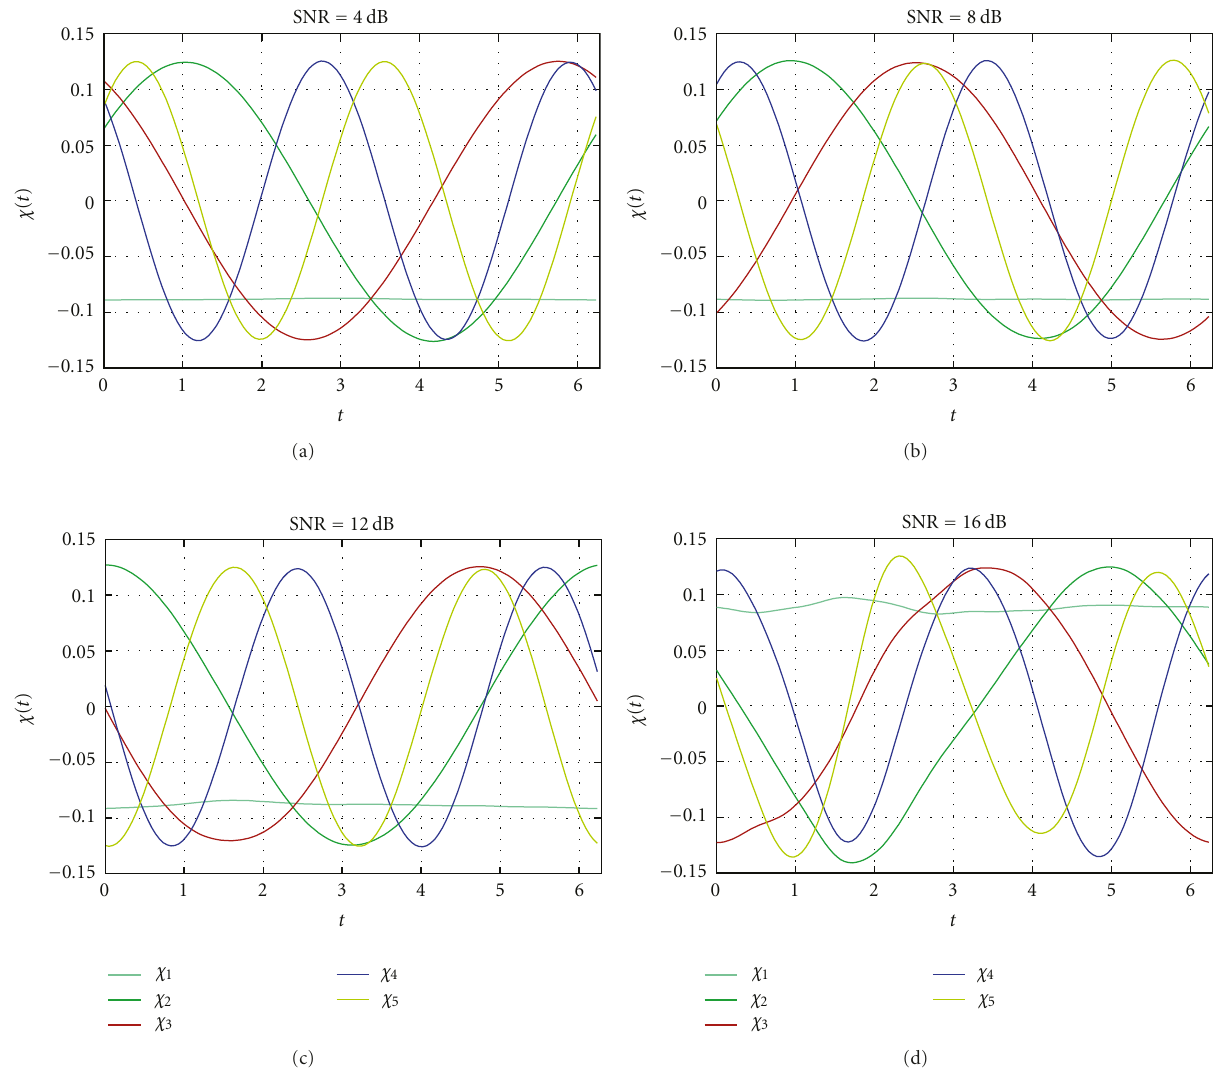
Figure 5: The obtained eigenfunctions of the MSK with di ff erent levels of